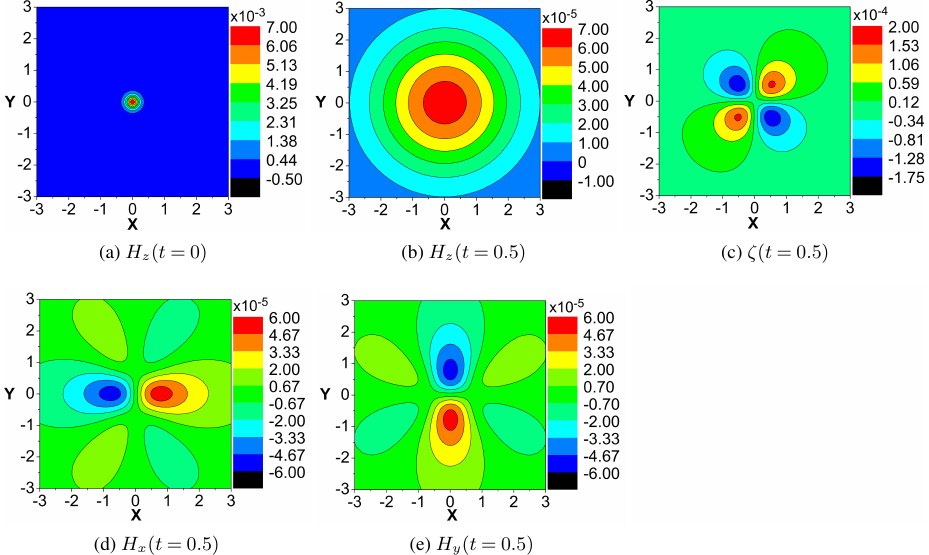
Fig. 3. Excitation of PEMW by means of vertical component of magnetic field. Spatial distributions of normalised components of magnetic field (H x ,H y ,H z ) and ζ at different times are shown at hight Z = 300km (night-time). X and Y are normalised by R = 6 . 4 × 10 3 km. Components of magnetic field H are normalised by H 0 = 3 × 10 4 nT. Dimensionless size of the source are ∆ x = 0 . 25 and ∆ y = 0 . 17 ; ∆ X 0 H = ∆ Y 0 H = 0 and θ = 0 . PEMW was excited by initial perturbation of H z ( H z ( t = 0) max = 0 . 01 ). Table 1: The ionosphere night time parameters.